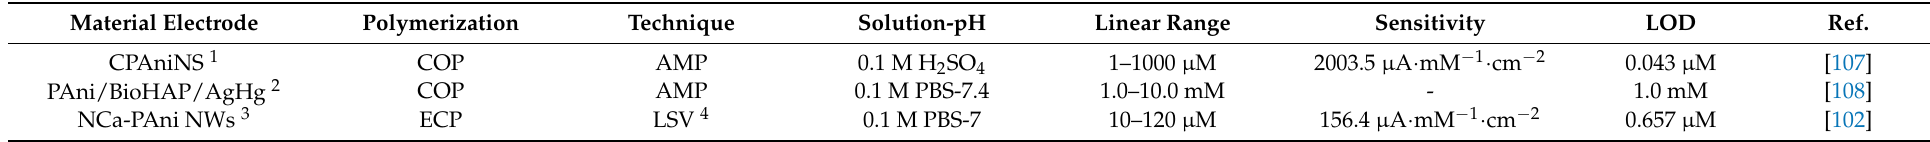
Table 2. Non-enzymatic PAni-based glucose biosensors.